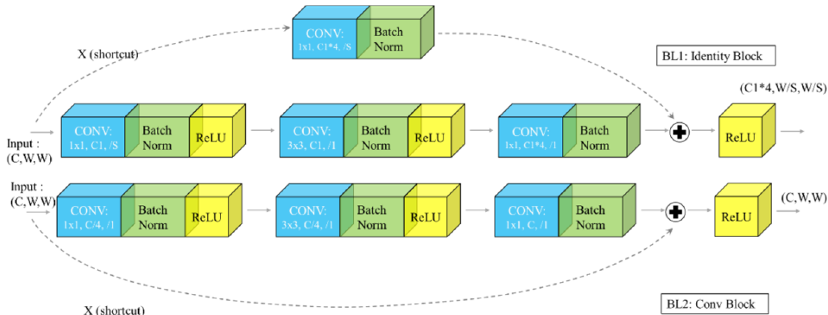
Figure 3. Two bottleneck structures of the DToolnet feature extraction network.